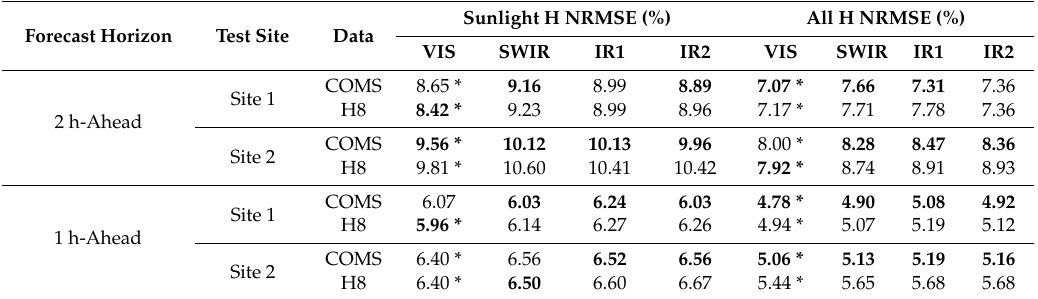
Table 6. NRMSE results from the PV forecast for COMS and H8 datasets using the DNN model in “Sunlight H” and “All H” time frames.